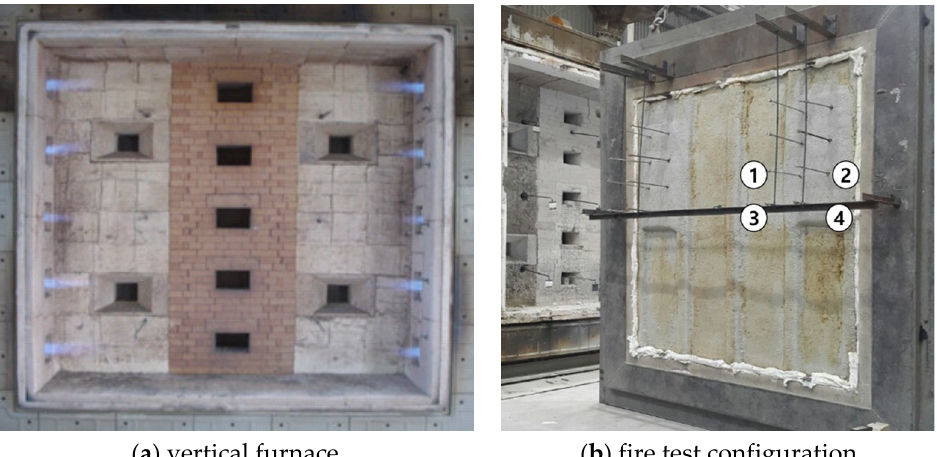
Figure 7. Fire test facility and configuration.